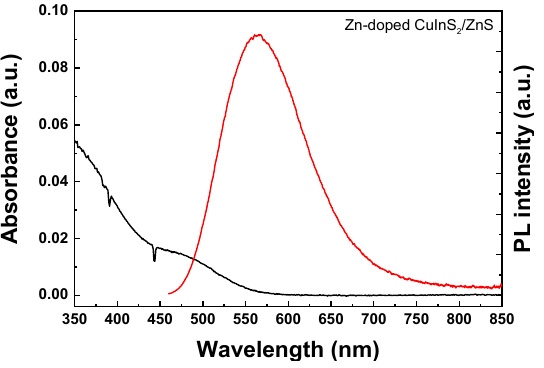
Figure 6. Absorption (black line) and PL (red line) spectra of Zn-doped CuInS 2 /ZnS C/S QDs. In this study, to investigate the applicability of ZnSe/ZnS C/S QDs for warm white LEDs, which can be used in the lighting field, we fabricated warm white LEDs by combining an nUV LED chip, ZnSe/ZnS C/S QDs, and ZCIS/ZnS C/S QDs. Figure 7 shows the optical properties of the warm white LEDs, which were evaluated at 60 mA. In the EL spectrum shown in Figure 7a, three peaks were observed. The peak in the nUV region is attributed to the nUV LED chip, and other peaks in the blue and yellow spectral regions are attributed to the ZnSe/ZnS C/S QDs and ZCIS/ZnS C/S QDs. Warm white light was emitted from the fabricated white LEDs due to a combination of characteristic emission peaks of the ZnSe/ZnS C/S QDs and ZCIS/ZnS C/S QDs (Figure 7a inset). When we inves- tigated the luminous efficacy of the fabricated warm white LEDs, we determined it was 3.7 lmW − 1 . Although this is not a high value, the luminous efficacy is affected by the effi- ciency of the nUV LED chip and coated QDs, etc. The luminous efficacy of white LEDs can be increased by using a highly efficient nUV LED chip and by enhancing the efficiency